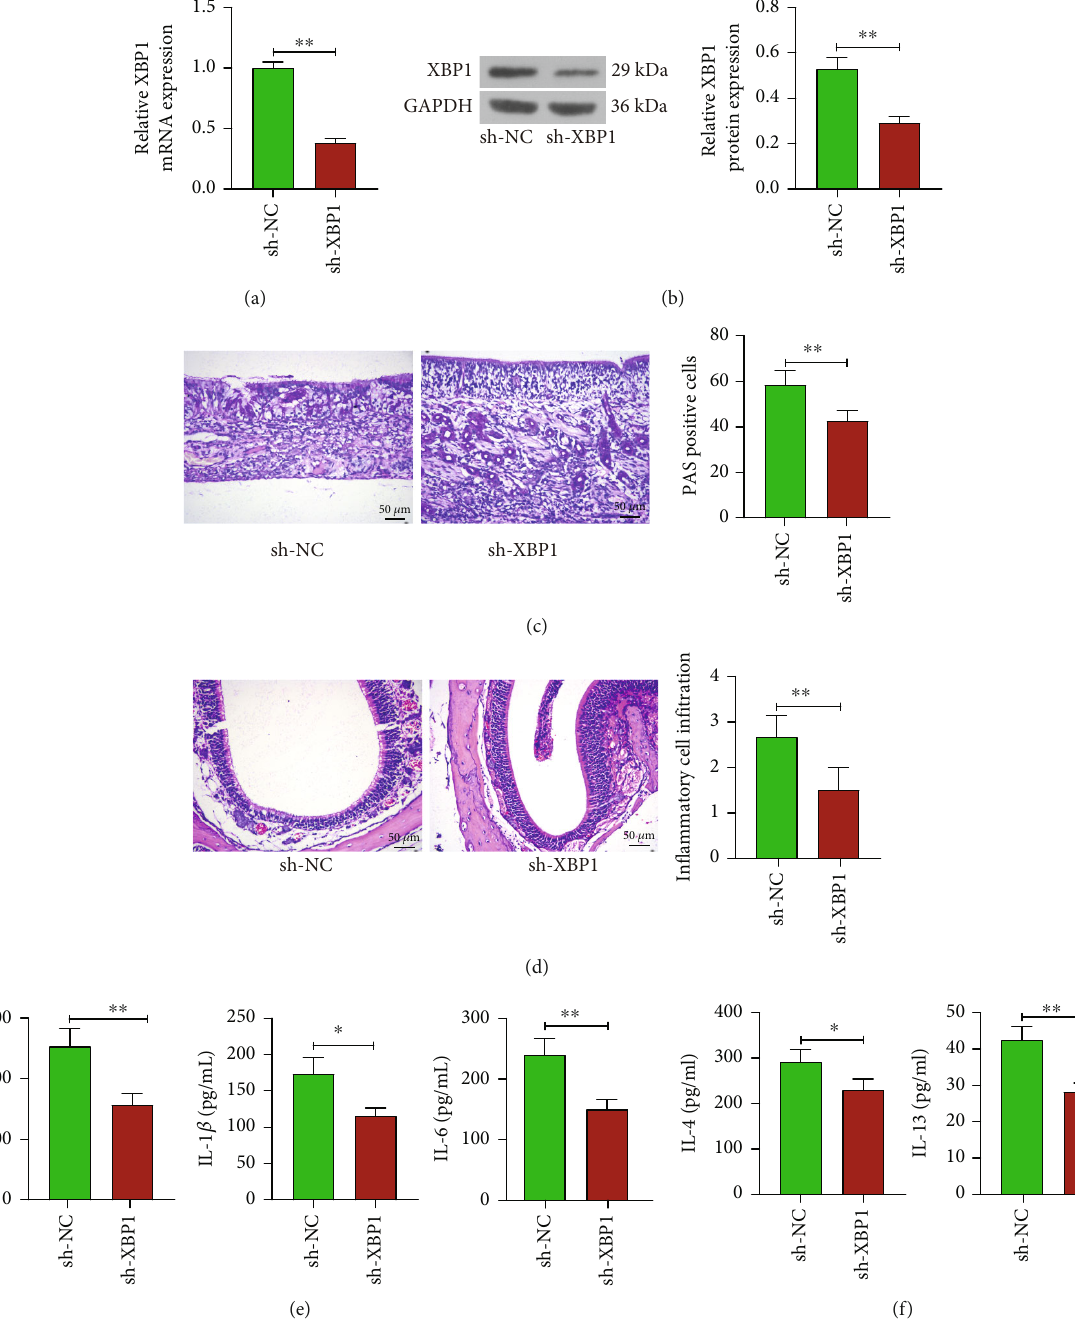
Figure 2: XBP1 knockdown alleviates the development of CRSsNP in mice. (a, b) Detection of mRNA and protein expression of XBP1 in nasal mucosa tissues of mice after downregulation of XBP1 by (a) RT-qPCR and (b) Western blot. (c) PAS staining analysis of mucin expression in nasal mucosal epithelial cells of mice. (d) Pathological changes of nasal mucosa in mice observed by HE staining. (e) The levels of in fl ammatory factors IFN- γ , IL-1 β , and IL-6 in nasal mucosal tissues of mice measured using ELISA. (f) The levels of in fl ammatory factors IL-4 and IL-13 in nasal mucosal tissues of mice measured using ELISA. ∗ p < 0 : 05 and ∗∗ p < 0 : 01 versus the CRSsNP mice administrated with sh-NC. The data are measurement data, presented as mean ± SD . Data between two groups were compared using an unpaired t test. The experiment was independently repeated three times. n = 6